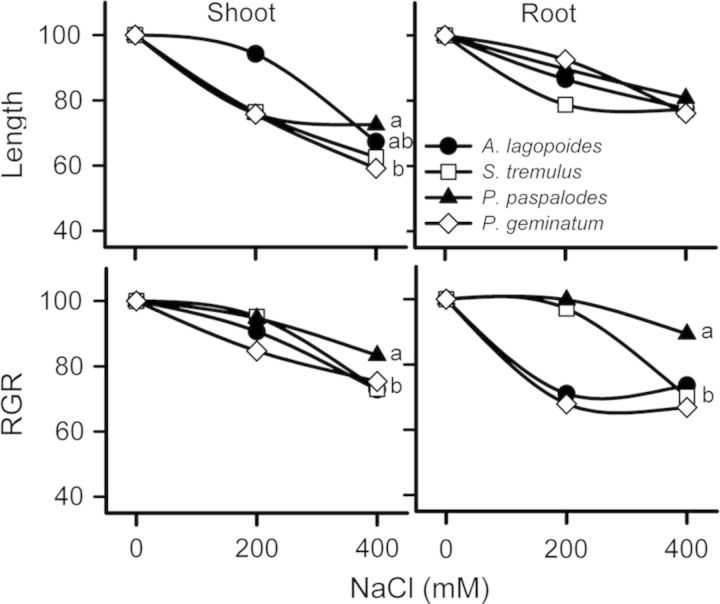
Percent change in the length and RGR of aboveground and belowground parts of the salt-excreting (A. lagopoides, S. tremulus) and non-excreting (P. paspalodes, P. geminatum) grasses grown under increasing salinity treatments (0, 200 and 400 mM NaCl). Different letters represent significant differences among species at P < 0.05 (Bonferroni test).